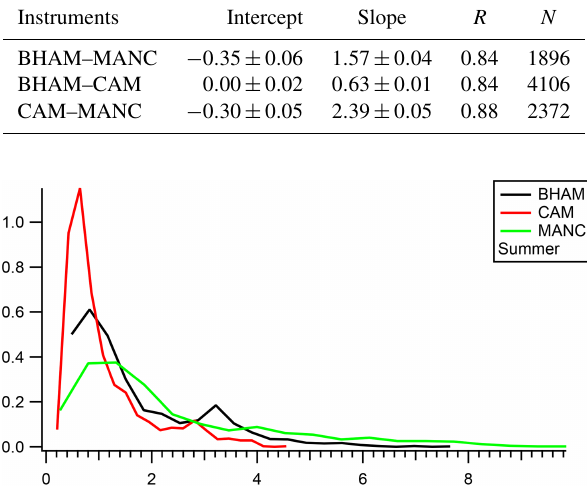
Table 7. RMA regression relationships of HONO measured by BHAM–CAMB–MANC for the whole summer period. Variability shown is the 95% confidence interval of the slope and intercepts.